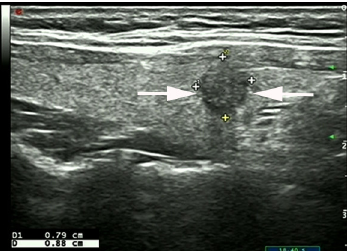
Figure 1. A 48-year-old woman with a PTMC with a taller-than-wide shape in the left thyroid lobe without suspicious thyroid capsule involvement sign (arrows). The patient underwent left central neck lymph node dissection, and the surgical–histopathologic results showed the absence of central neck lymph node metastases. PTMC: papillary thyroid microcarcinoma.